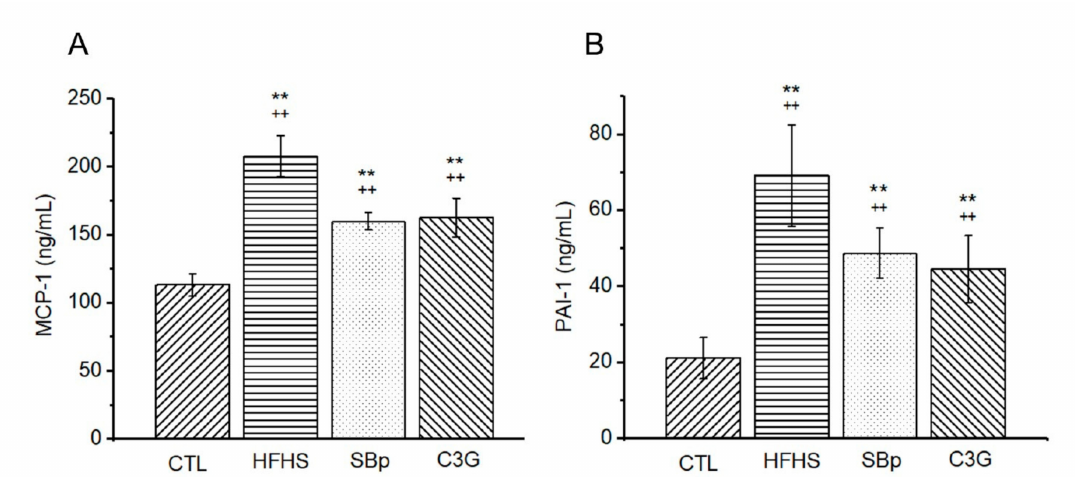
Figure 4. Levels of inflammatory regulators in plasma of mice receiving the HFHS diet supplemented with C3G. The experimental regimen was described in the legend of Figure 1. The levels of monocyte chemotactic protein-1 (MCP-1) and plasminogen activator inhibitor-1 (PAI-1) were analyzed in plasma collected before tissue harvesting using enzyme-linked immunosorbent assay (ELISA) kits for mouse MCP-1 ( A ) or PAI-1 ( B ). Values are expressed as mean ± SD ng / mL ( n = 8 / group). **: p < 0.01 versus the control (CTL) group; ++ : p < 0.05 or 0.01 versus the HFHS